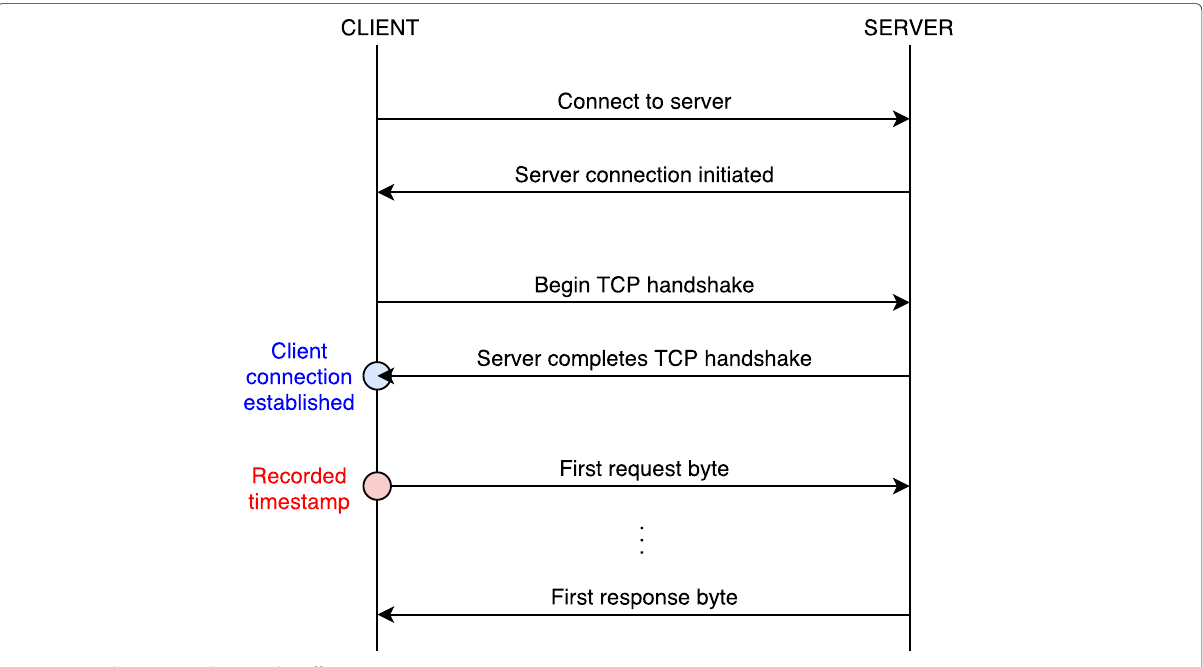
Fig. 3 T 1 and T 2 captured network